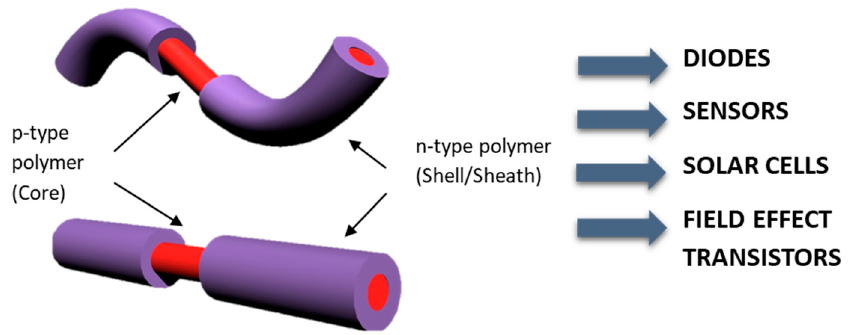
Figure 3. P- and n-type coaxial nanofiber semiconducting polymers formed as a nanofiber provide an opportunity for the formation of a p-n junction that can be chained for electroactive textiles and single nanofiber devices. Reprinted from [64].